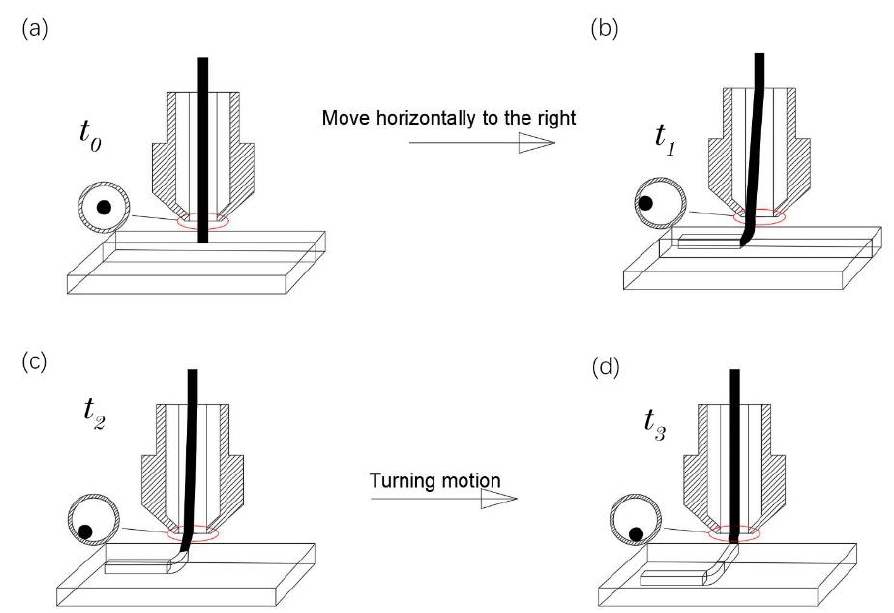
Figure 12. Corner motion model, ( a ) initial printing state, ( b ) straight line printing status, ( c ) initial turning state, ( d ) turning completion state.